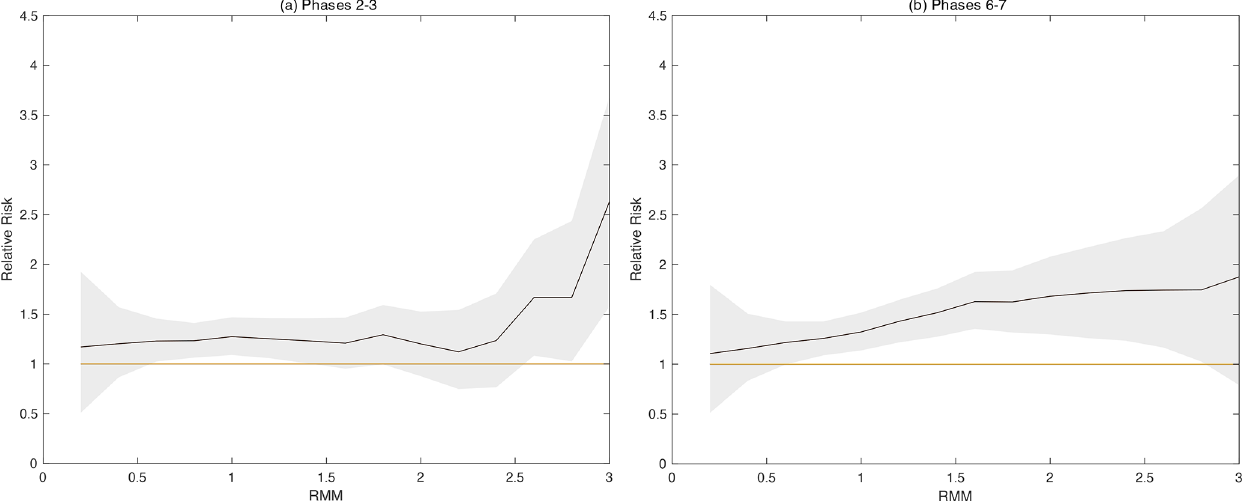
Figure 9. As in Fig. 7 but for weeks 3–4 expected skill and for varying RMM amplitude during either (a) MJO phases 2–3 or (b) MJO phases